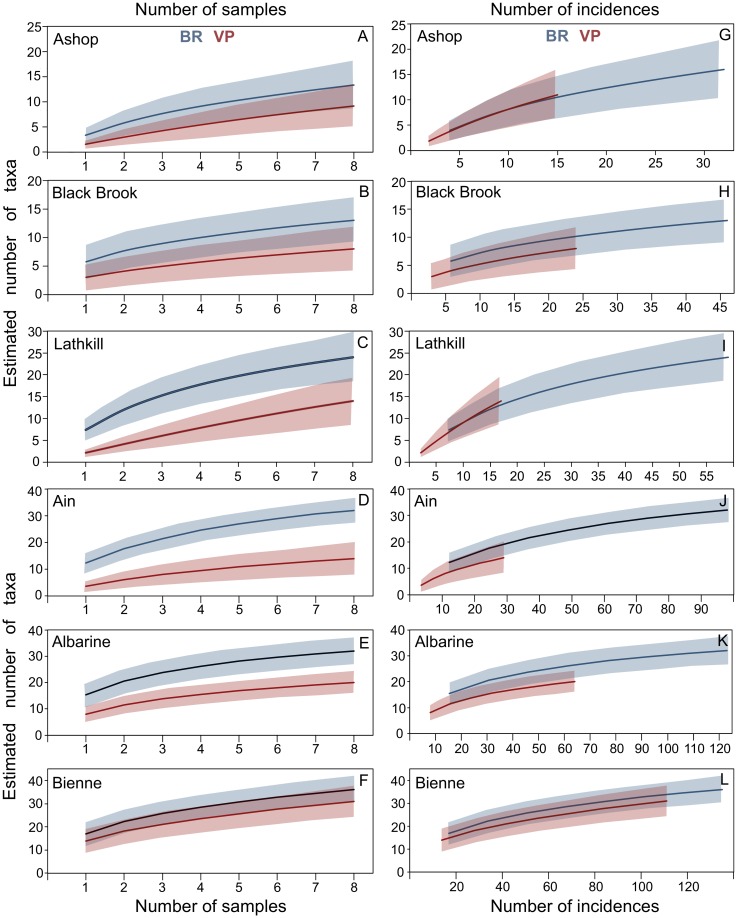
Rarefaction curves of taxa richness, for samples collected using two hyporheic macroinvertebrate pump-sampling techniques, Bou-Rouch (BR, blue) and vacuum-pump (VP, red) sampling.Sample-based incidence curves for: (A) the Ashop; (B) Black Brook; (C) the Lathkill; (D) the Ain; (E) the Albarine; (F) the Bienne; and sample-based incidence curves rescaled to the number of incidences, for: (G) the Ashop; (H) Black Brook; (I) the Lathkill; (J) the Ain; (K) the Albarine; (L) the Bienne. To allow rescaling to produce smooth curves, the expected number of incidences in t samples was calculated as (t / total number of samples)*total number of incidences. Solid lines indicate the estimated number of taxa; shaded areas indicate upper and lower 95% CIs.